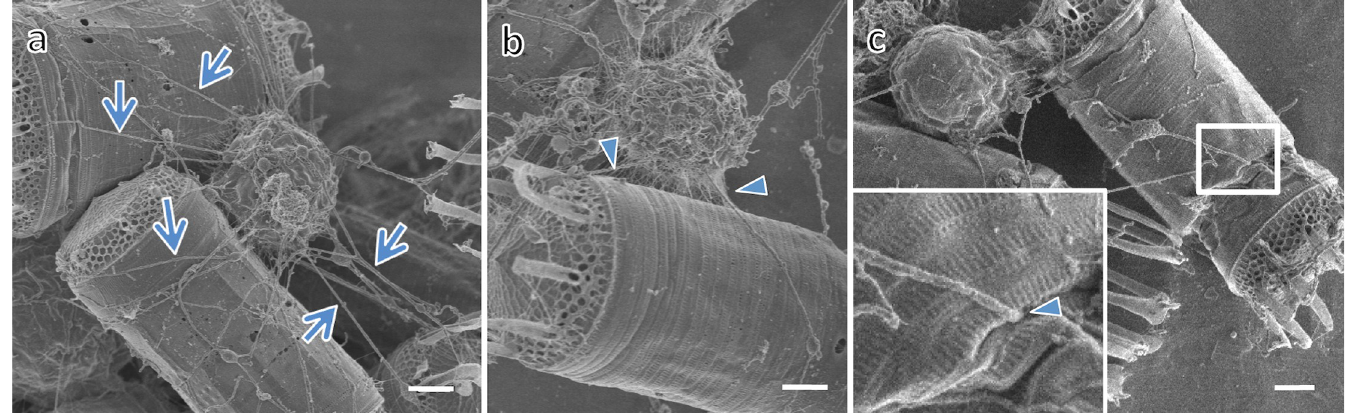
Fig 5. Scanning electron micrographs showing ectoplasmic nets of Aplanochytrium cells attacking diatoms. (a–b) Aplanochytrium (SEK 717) cells adhering to Skeletonema cells via thick web-like (arrows) and fine (arrowheads) ectoplasmic nets. (c) Tip of thick ectoplasmic net penetrating into Skeletonema cell (penetration site is shown at high magnification). Scale bar = 1 μ m.